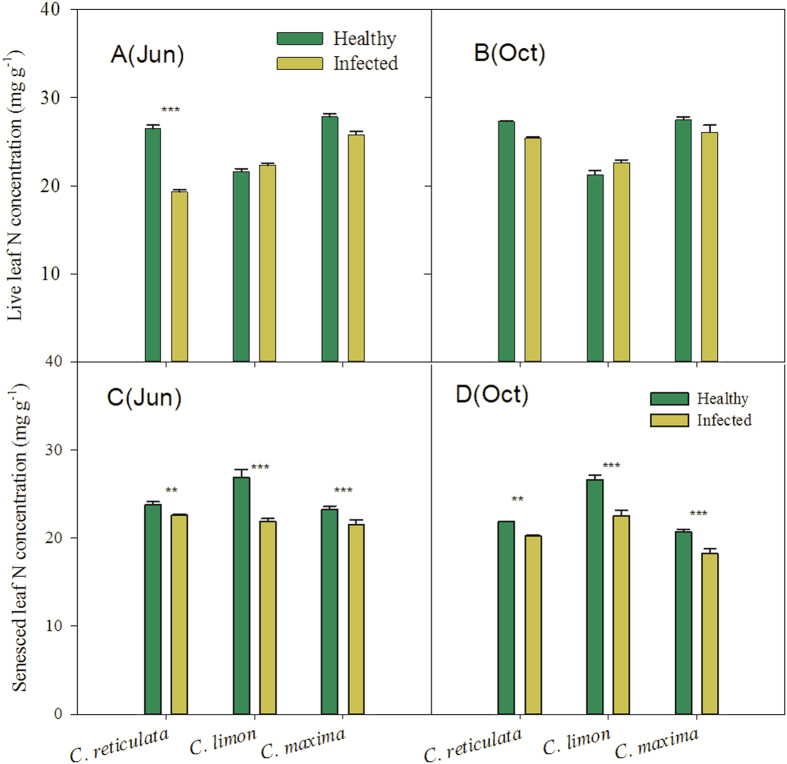
N concentrations in live- and senesced-leaves of different citrus species.Values are mean ± Se, n = 5. *, ** and *** above bars indicate significant differences at P < 0.05, 0.01 and 0.001, respectively, derived from the results of paired t-tests.